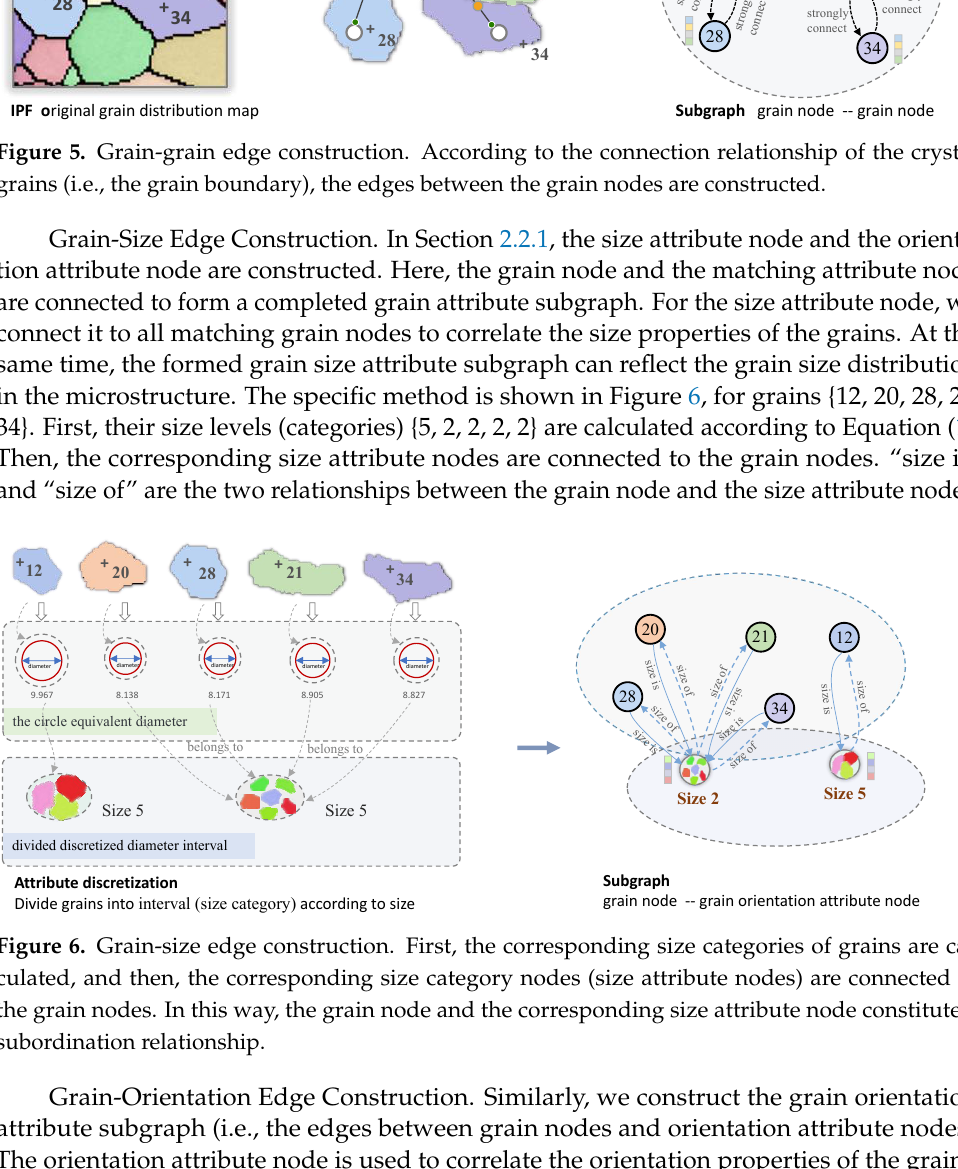
Subgraph grain node -- grain node IPF o riginal grain distribution map